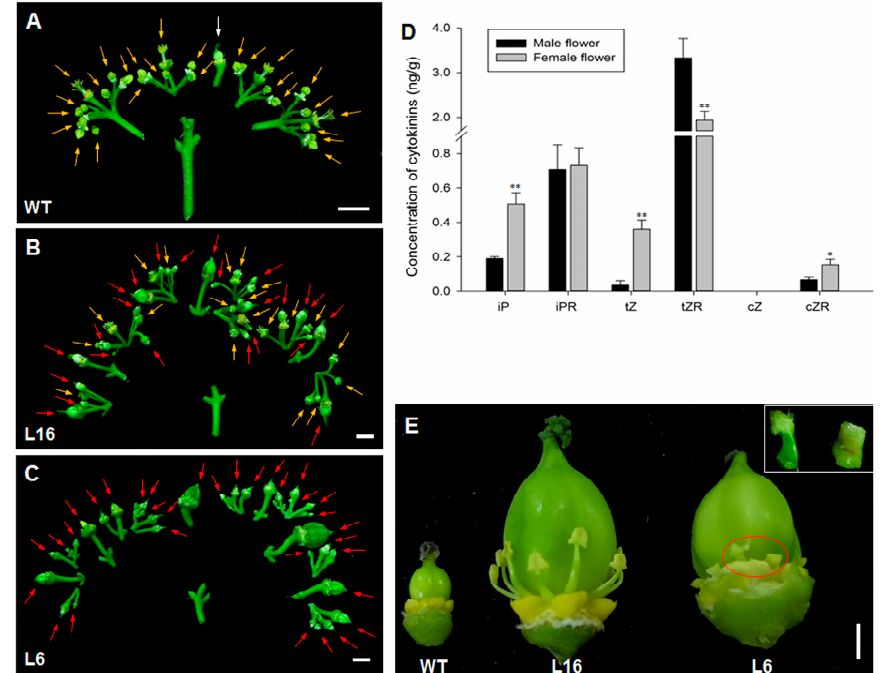
Figure 4. JcTM6:AtIPT4 transgenic J. curcas produced bisexual flowers. ( A – C ) Branch of an inflorescence from the WT ( A ), L16 ( B ), and L6 ( C ) plants. For clarity, the sepals and petals were removed from the flowers. Yellow arrows indicate male flowers; white arrow indicates female flower; and red arrows indicate bisexual flowers; scale bars = 1 cm. ( D ) Cytokinin levels in male and female flowers of WT plants. The values represent the means ± standard deviations ( n = 3). Student’s t -test was used for the statistical analyses: * p ≤ 0.05, ** p ≤ 0.01. ( E ) Female flowers of the WT plants and bisexual flowers of the L16 and L6 plants after the sepals and petals were removed. The inset shows the stamens marked by red ellipse; scale bar = 3 mm. Table 1. Numbers of male, female, and bisexual flowers per inflorescence in the WT plants and the transgenic lines L16 and L6.